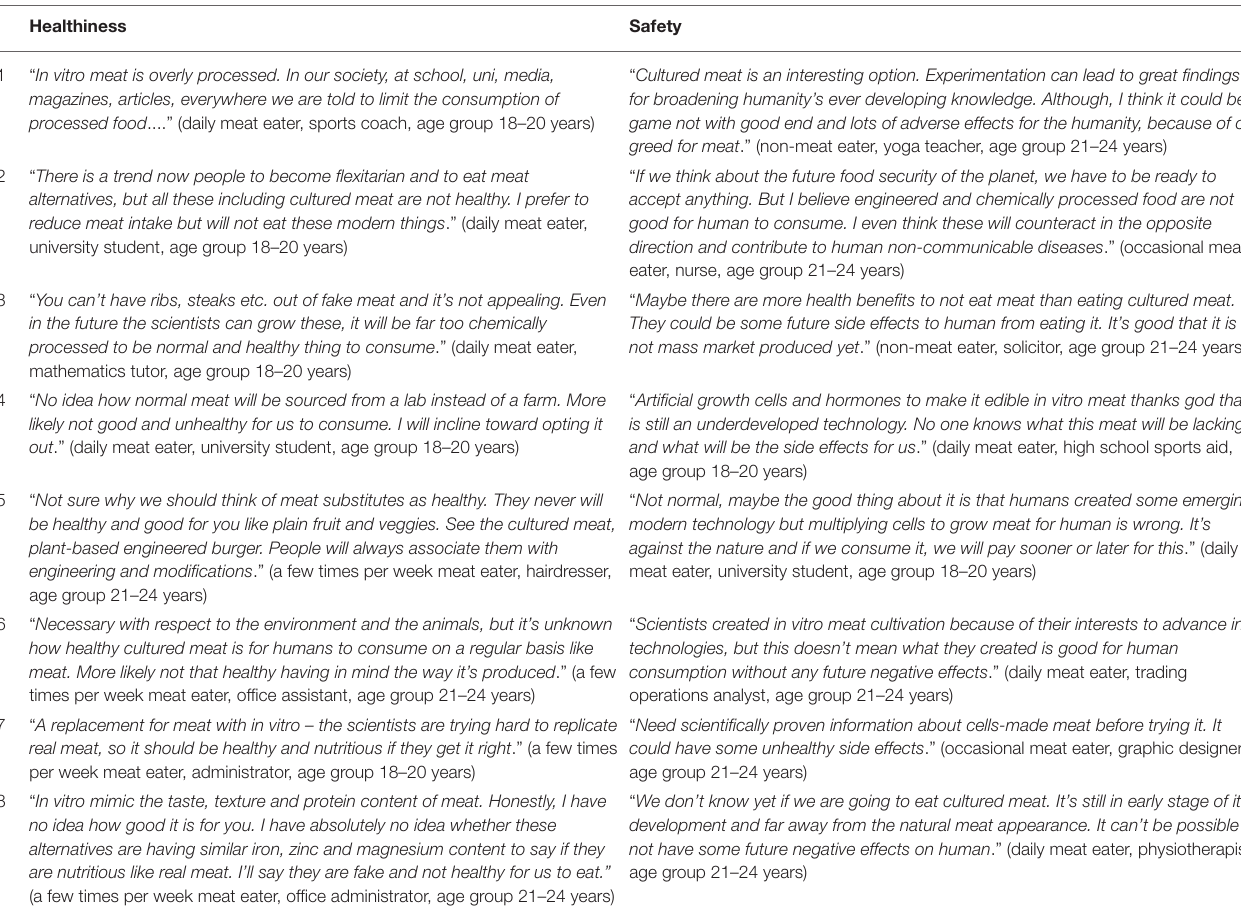
TABLE 3 | Sydney Gen Z’s perceptions about healthiness and safety of cultured